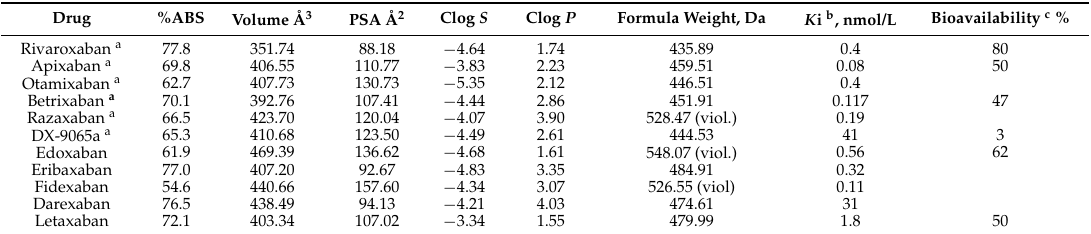
Table 6. Calculated molecular descriptors and experimental biochemical activity ( K i) of the novel anticoagulants.